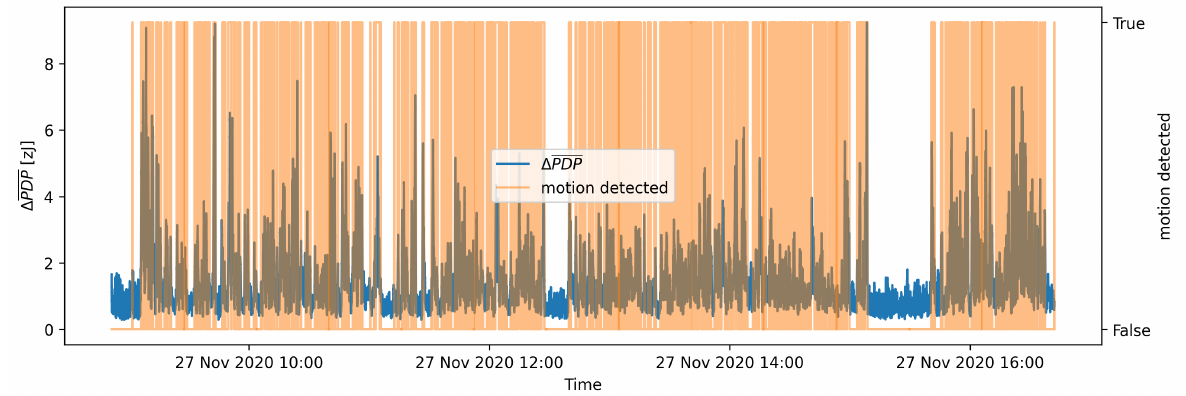
Figure 12. Results of the OAMD algorithm with k = 5 for a part of the validation data